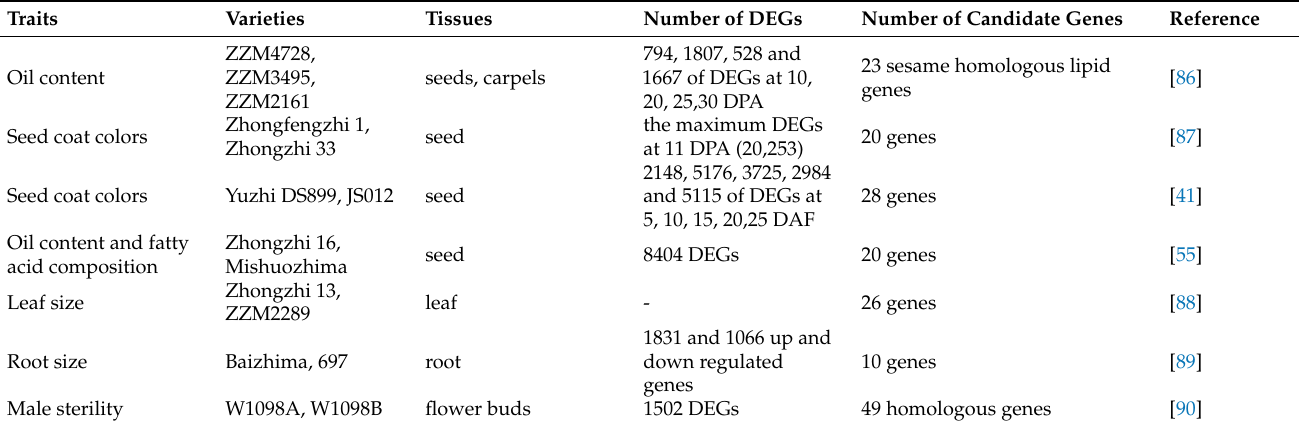
Table 6. Summary of transcriptome-based organ development studies in